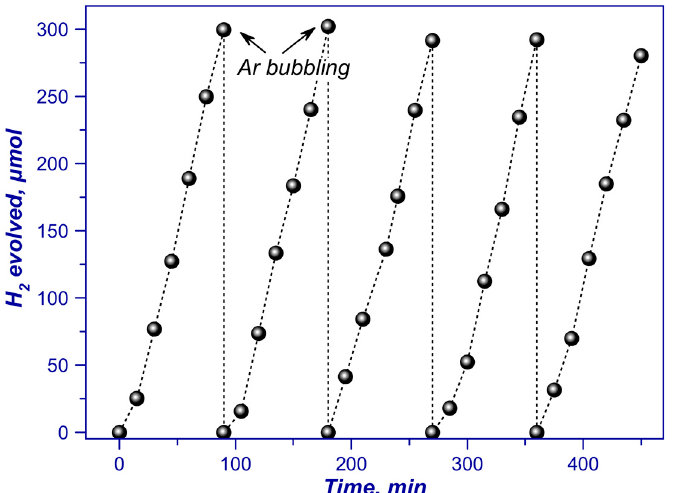
Figure 6. Stability of the 0.5% Pt/g-C 3 N 4 (T = 400 °C) photocatalyst in five 1.5 h cycles of hydrogen production. Adapted with permission from Ref. [102]. 2022, Elsevier.